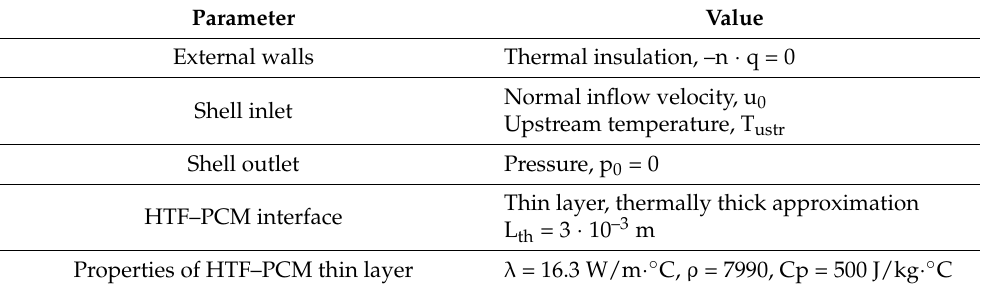
Table 4. Boundary